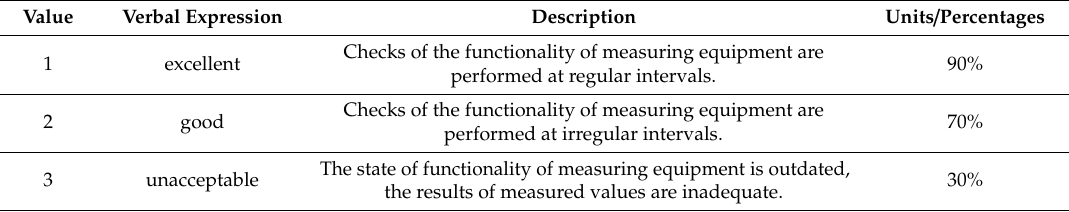
Table 4. Indicator—Status of equipment for measuring meteorological